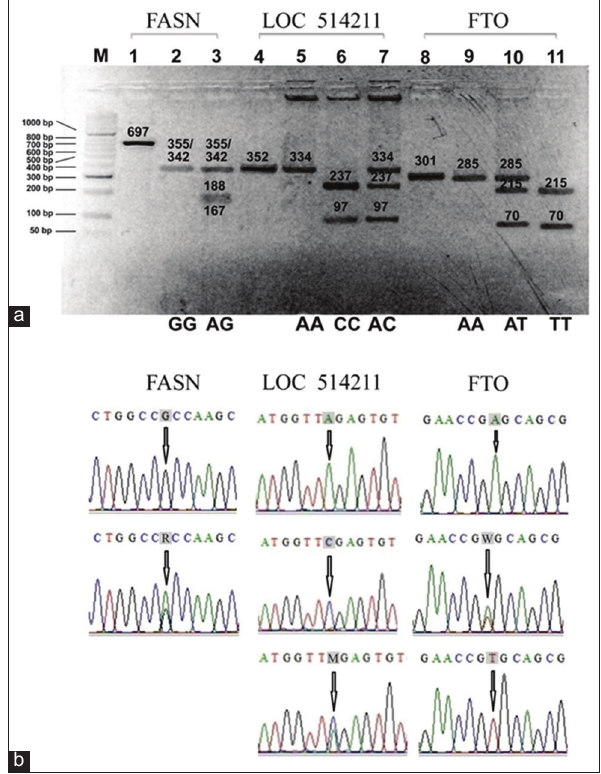
Figure-1: Representative results of polymerase chain reaction-restriction fragment length polymorphism (PCR- RFLP) following (a) electrophoresis. All numbers in the box in units of bp. M: 50 bp DNA marker; 1, 4, and 8: PCR products; 2-3: PCR-RFLP FASN-MscI; 5-7: PCR-RFLP LOC514211-TaqI; 9-11: PCR-RFLP FTO-HPyCH4III; (b) sequencing.